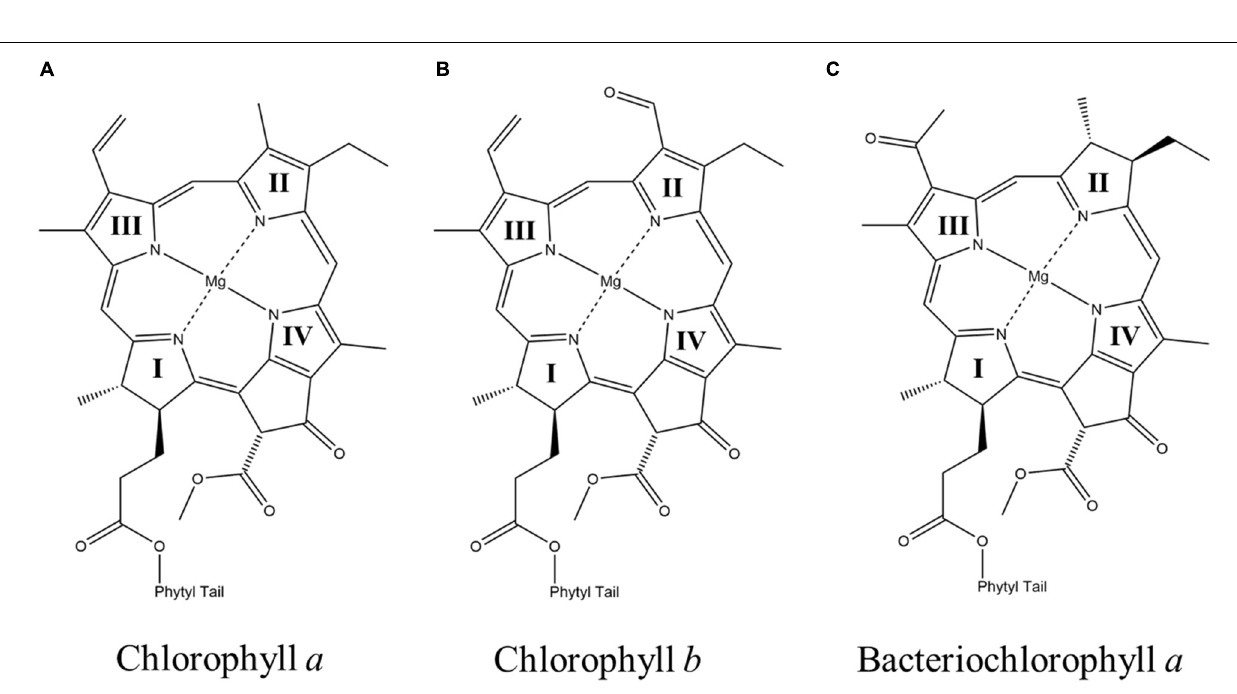
Frontiers in Microbiology |